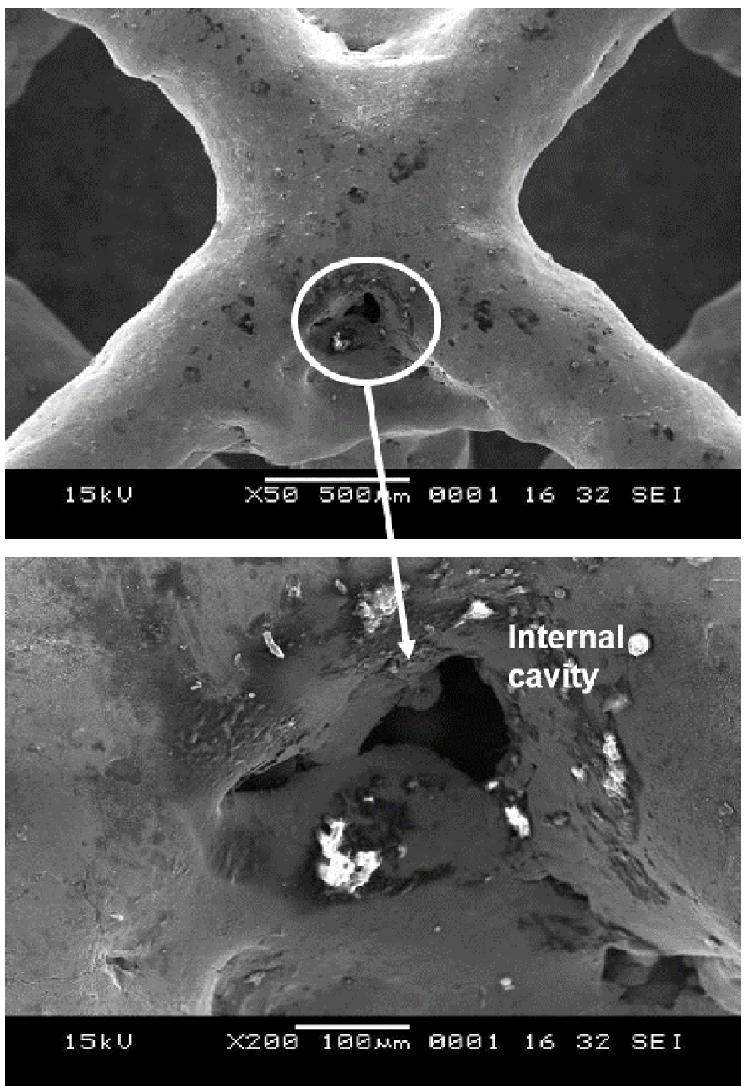
Figure 13. Amplification of internal cavities with sandblasting followed by electropolishing (experi- ment 1B).